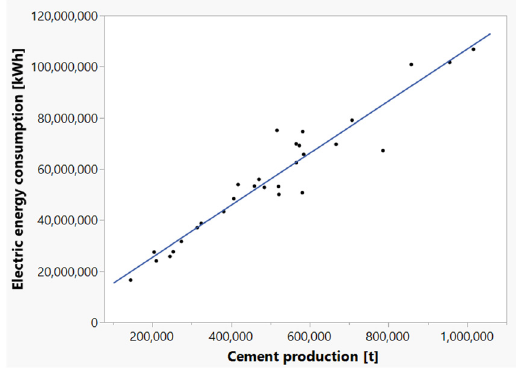
Figure 15. NACE 23.51 linear regression of site electric consumption.